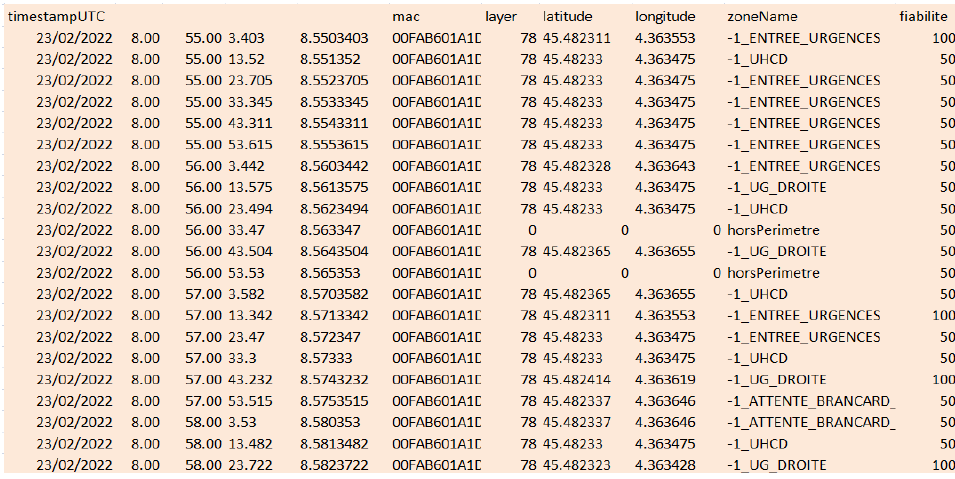
Figure 11. Detail of typical available data.